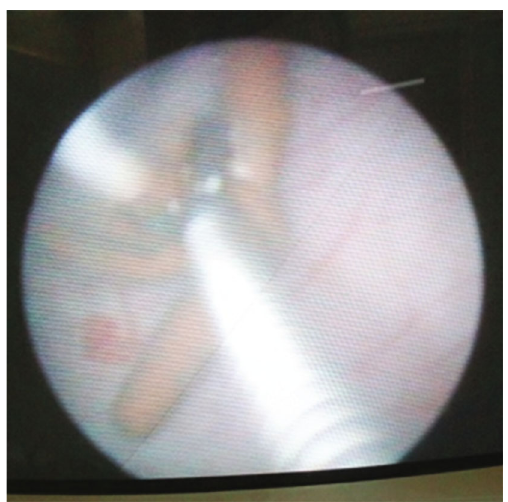
Figure 3: Intrauterine device grasped with forceps.